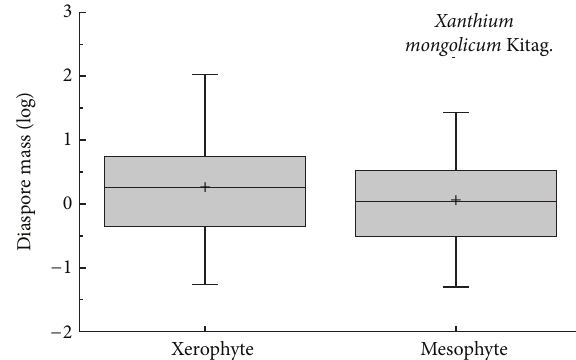
Figure 1: Box plots showing mean (+), median (—), quartiles, and outliers (-) of diaspore mass of 150 species grouped by different APG II taxonomic phylogeny group. Because Coniferopsida and Rosids are only one species, they do not compare with others.